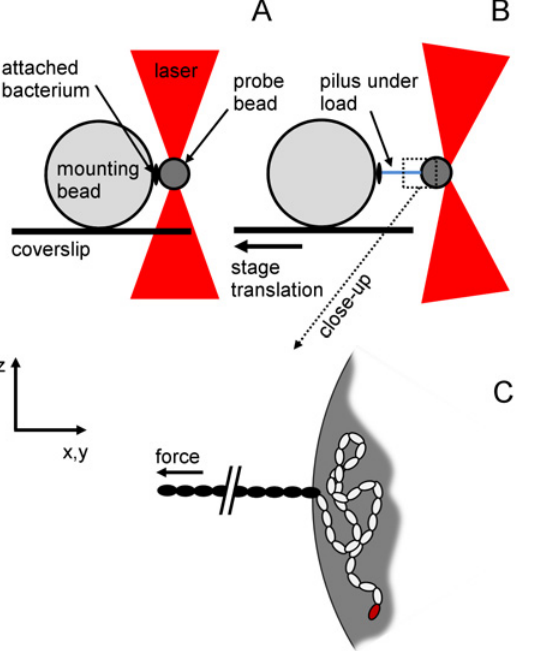
Fig 2. Experimental configuration of single-molecule force spectroscopy assays. Scheme illustrating the measurement configuration that was used during the experiments with no force applied (A) and under force (B) when the stage was moving. C is a close-up of B.). The pilus attached to the trapped bead is disproportionally long for reasons of depiction. The 10.5- μ m mounting bead (MB) was immobilized on the coverslip while the 1- μ m probe bead (PB) was trapped by optical tweezers (OT). A piliated bacterium was non-specifically attached to the MB and a pilus to the PB. When the coverslip was moved, and the trap kept in a fixed position, a force was directly exerted on the pilus. (C) Assuming adhesion to be non-specific, the most likely situation is that a portion of the pilus was attached (white subunits) and not solely the adhesion pilin (red subunit). Only a part of the pilus (black subunits) was thus subjected to the applied